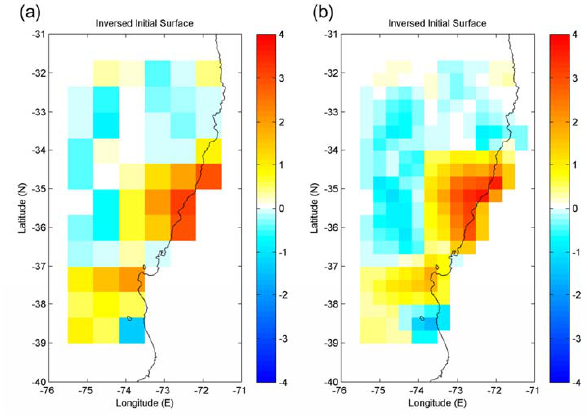
Fig. 9. (a) The inversion result with SUTIM of vertical displace- ment and aftershocks of the 27 February 2010 event. (b) the in- Figure 9. (a) The inversion result with SUTIM of vertical displacement and aftershocks of the 3 version results with SUTIM in gray and from traditional tsunami source determination method presented in counter lines. The blue February 27, 2010 event. (b) the inversion results with SUTIM in gray and from traditional 4 circle is the epicenter location reported by Global tsunami source determination method presented in counter lines. The blue circle is the 5 epicenter location reported by Global CMT. 6